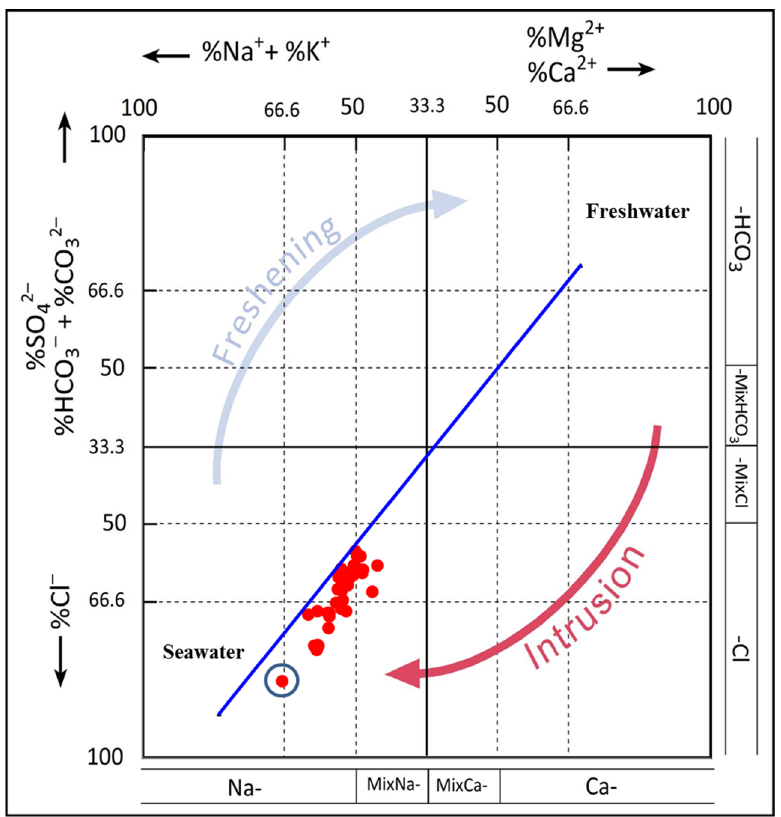
Figure 10. Hydrochemical Facies Evolution Diagram (HFE) of the tested GW samples. Seawater sample indicated with a red circle.